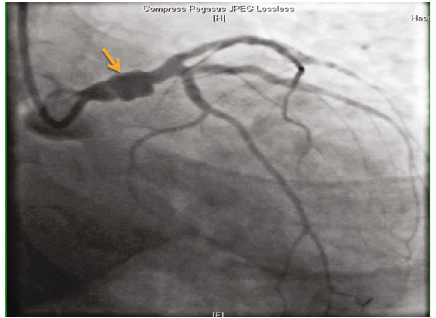
Figure 3: AP caudal view showing left main coronary artery